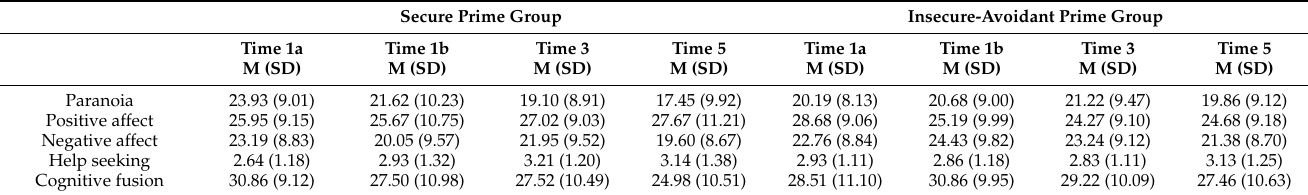
Table 2. Descriptive statistics for state measures pre- and